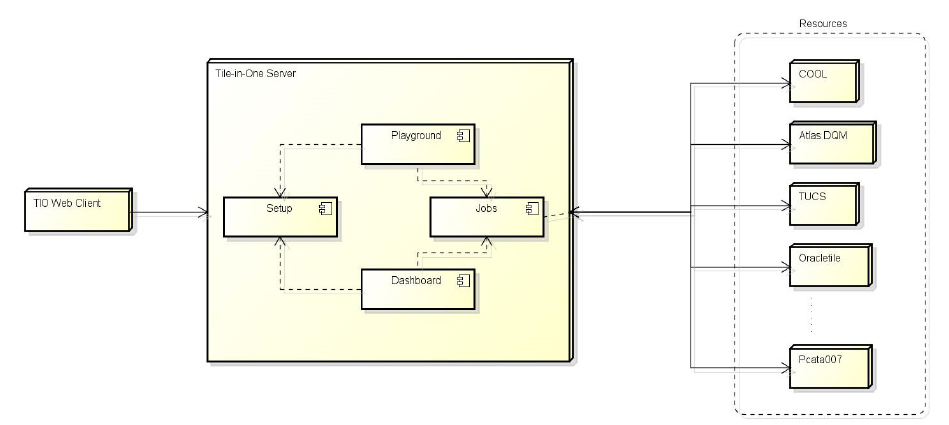
Figure 3. The diagram of the current Tile-in-One